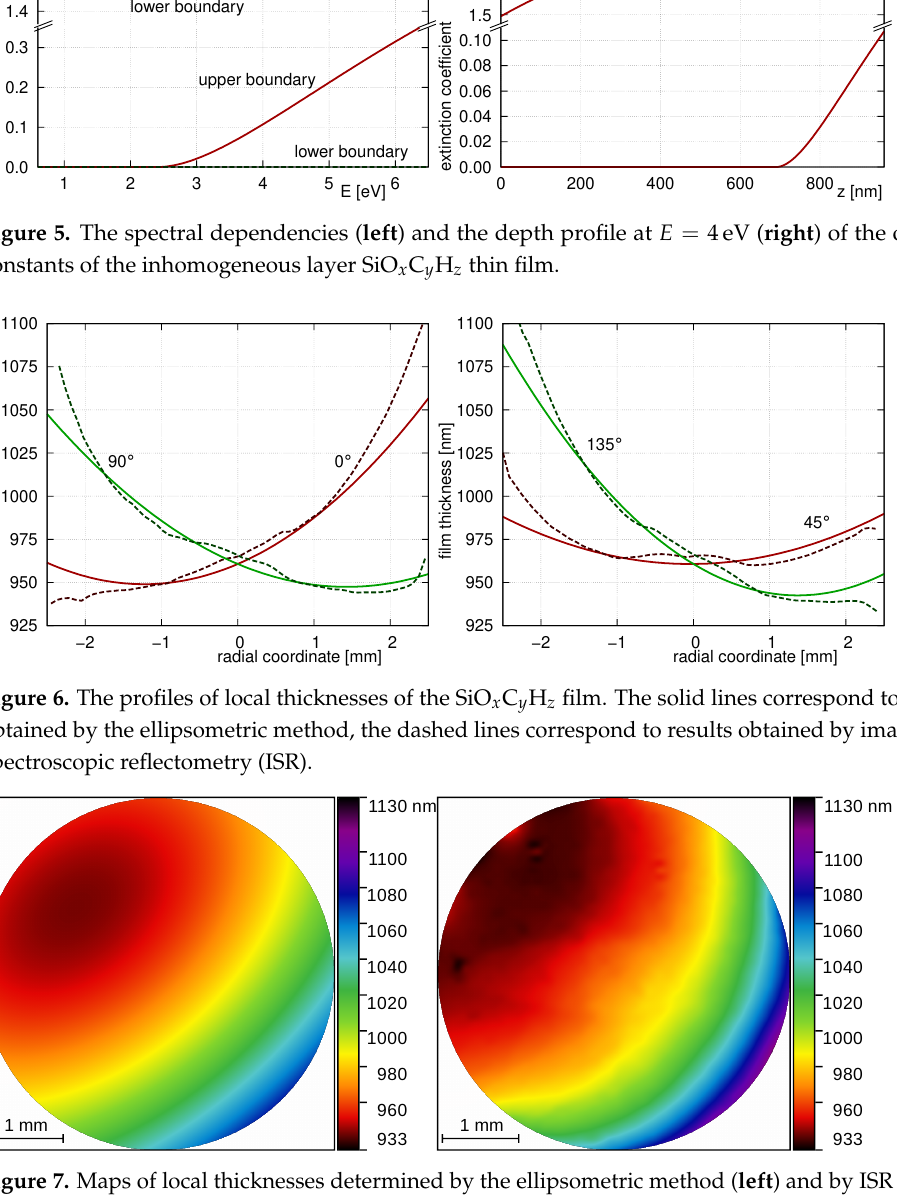
Figure 7. Maps of local thicknesses determined by the ellipsometric method ( left ) and by ISR ( right ) for the SiO x C y H z